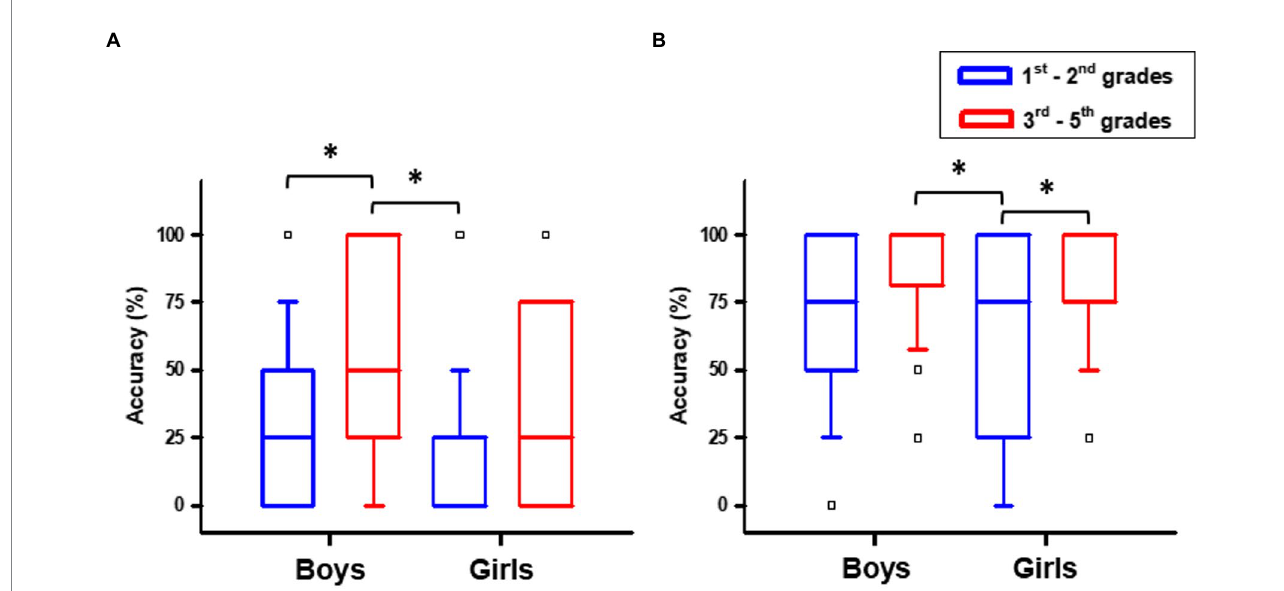
FIGURE 2 Test scores by age and sex: (A) rotation and (B) mirror task.